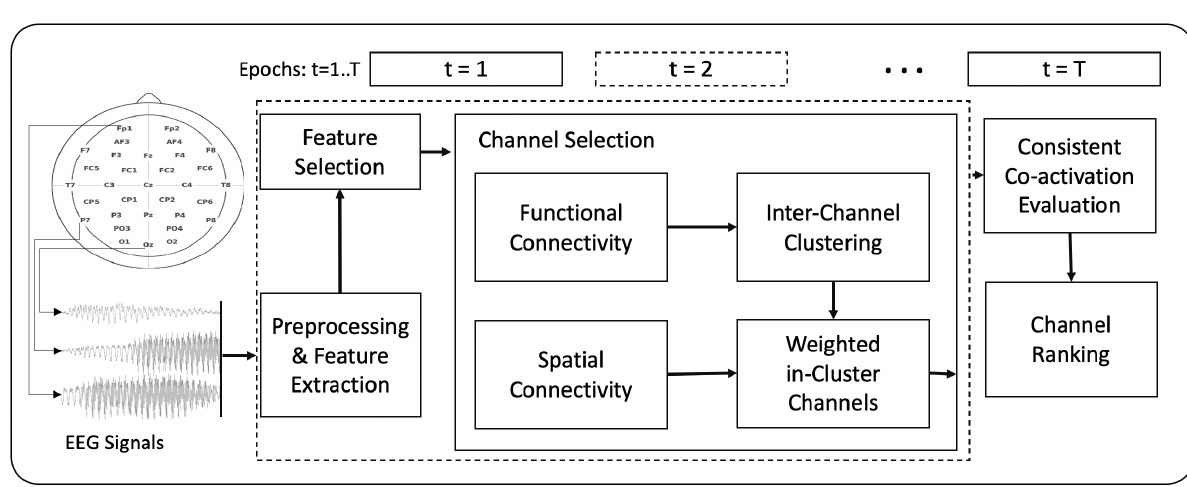
Fig 2. A general diagram of the proposed channel selection algorithm. The dotted box corresponds to a specific window of time (e.g., t = 2).